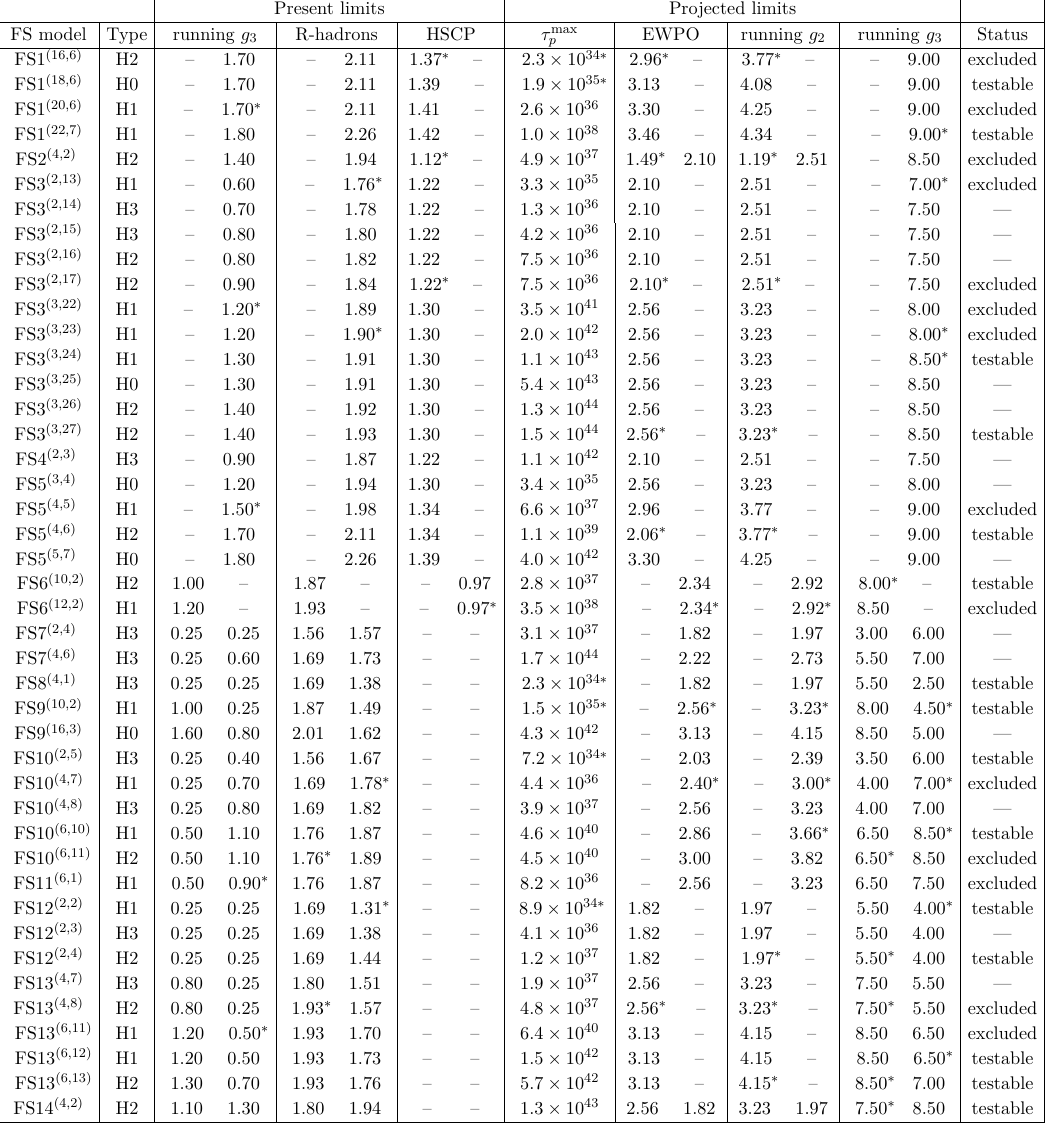
Table 6 . Scenarios with one VL fermion representation and one scalar representation that allow for the PGU ( (cid:15) 1% ) and the associated unification scale lies in the range 10 15 – 10 18 GeV . GUT ≤ The VL masses vary between 0.25 TeV and 10 TeV . In column 2 type of the model spectrum is given, as defined in eq. (2.12). In columns 3, 4 and 5 current lower bounds on the BSM masses (in TeV) are presented, as provided by the measurement of the running coupling g [37], R-hadrons [41] 3 and charged HCSP [41] searches, respectively. In column 6 the maximal proton lifetime (in years) is quoted in the PGU region of a given model. Projected sensitivities to the measurement of the running coupling g [42], the EWPO [43] tests and determination of g [40] at the future 100 TeV 2 3 collider are collected in columns 7, 8 and 9. Finally, in column 10 we indicate whether a given model is excluded by the current experimental data, or if it will be entirely tested in the future. The experimental bound responsible for the exclusion (testability) of a model is indicated with an asterisk. ( Continued on the next page